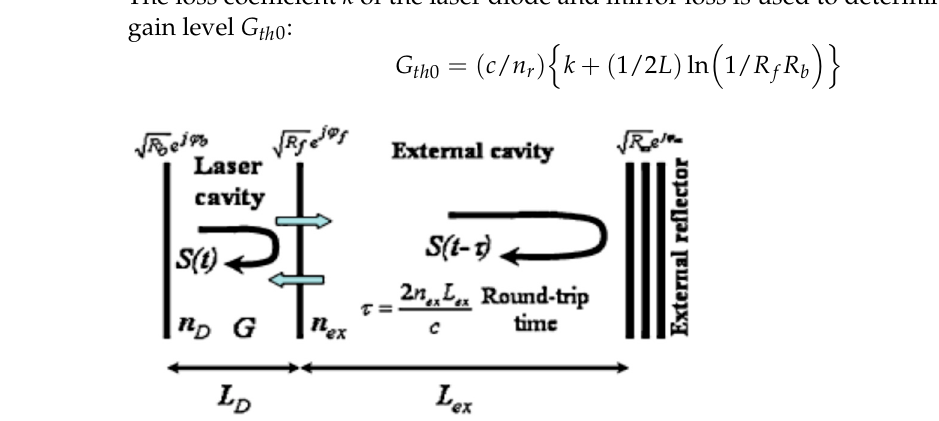
Figure 1. Model of an SL under external OFB.